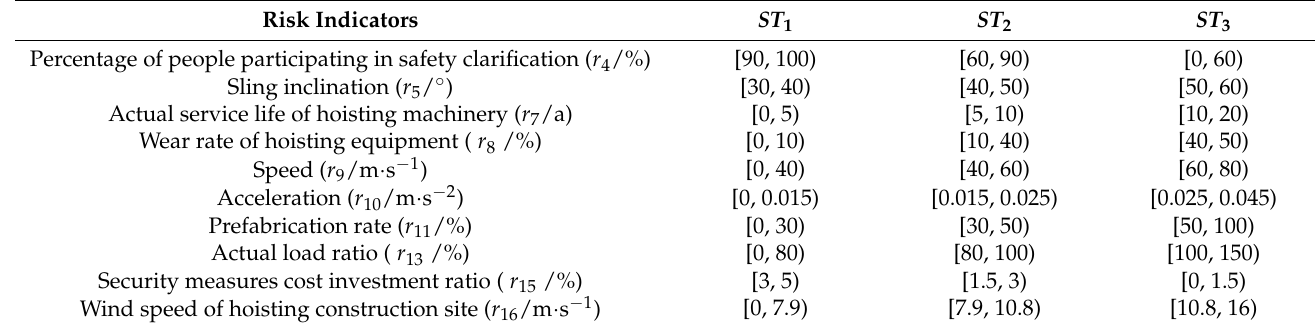
Table 4. Continuous variable risk state